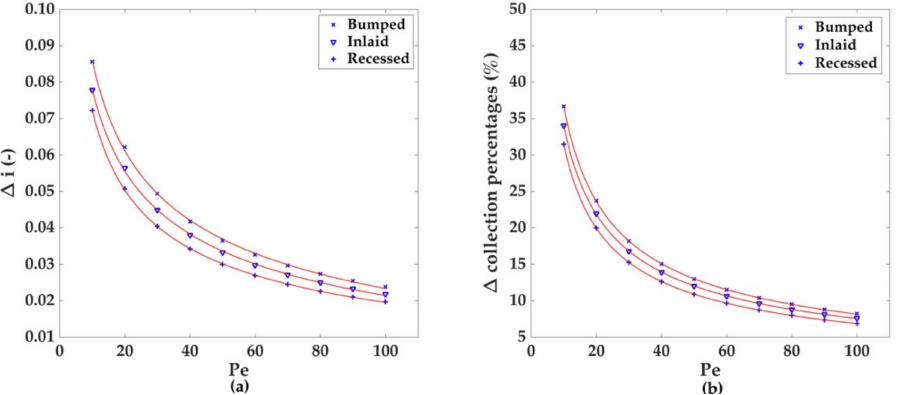
Figure 6. Difference between the values for the dimensionless currents ( a ) and collection percentages ( b ) obtained for A = 1 and A = 5 du at different values of the P é clet number. The data obtained for the three electrodic geometries were fitted using the power law decay y = m • x n + c (Table